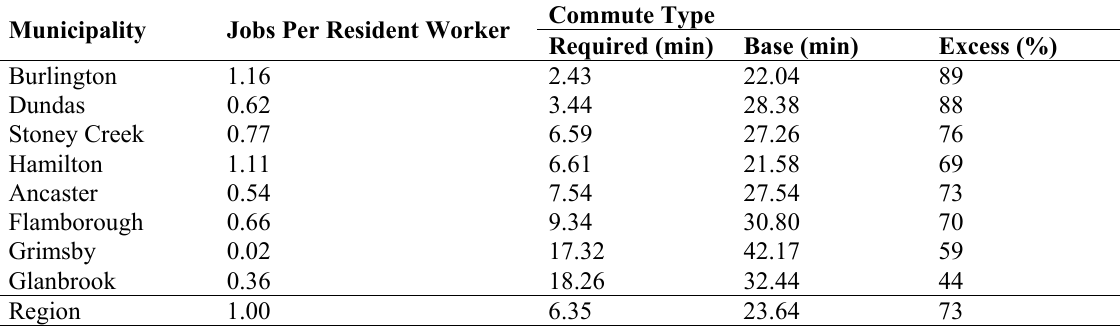
Table 6. Excess commuting for workers residing in municipalities of the Hamilton CMA (Scott et al.